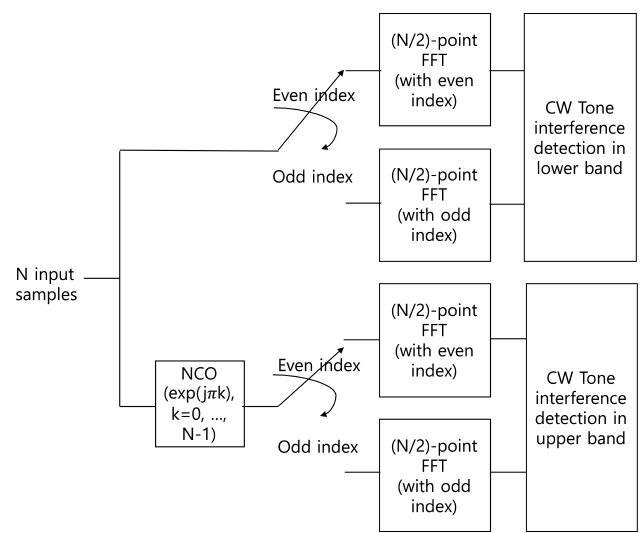
Figure 6. Overall structure of the proposed interference detector where N = 1024.